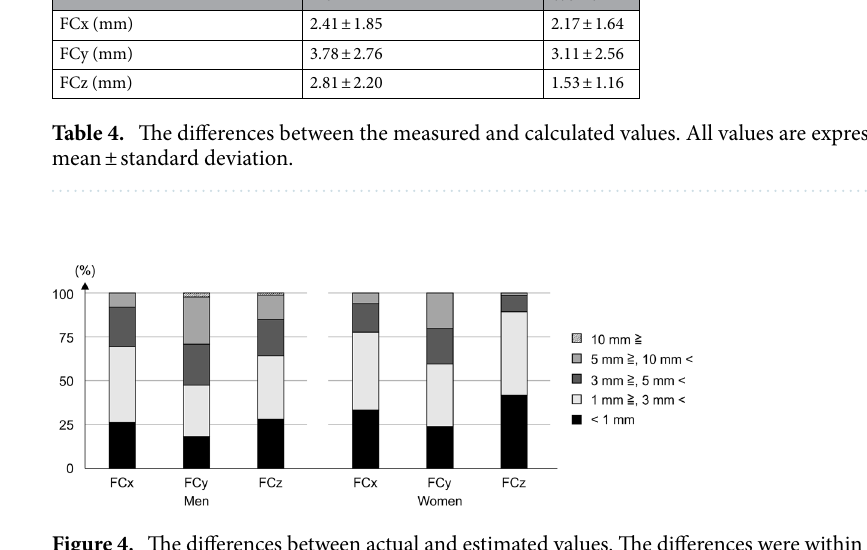
Figure 4. The differences between actual and estimated values. The differences were within 5 mm in FCx and FCz among both men and women.